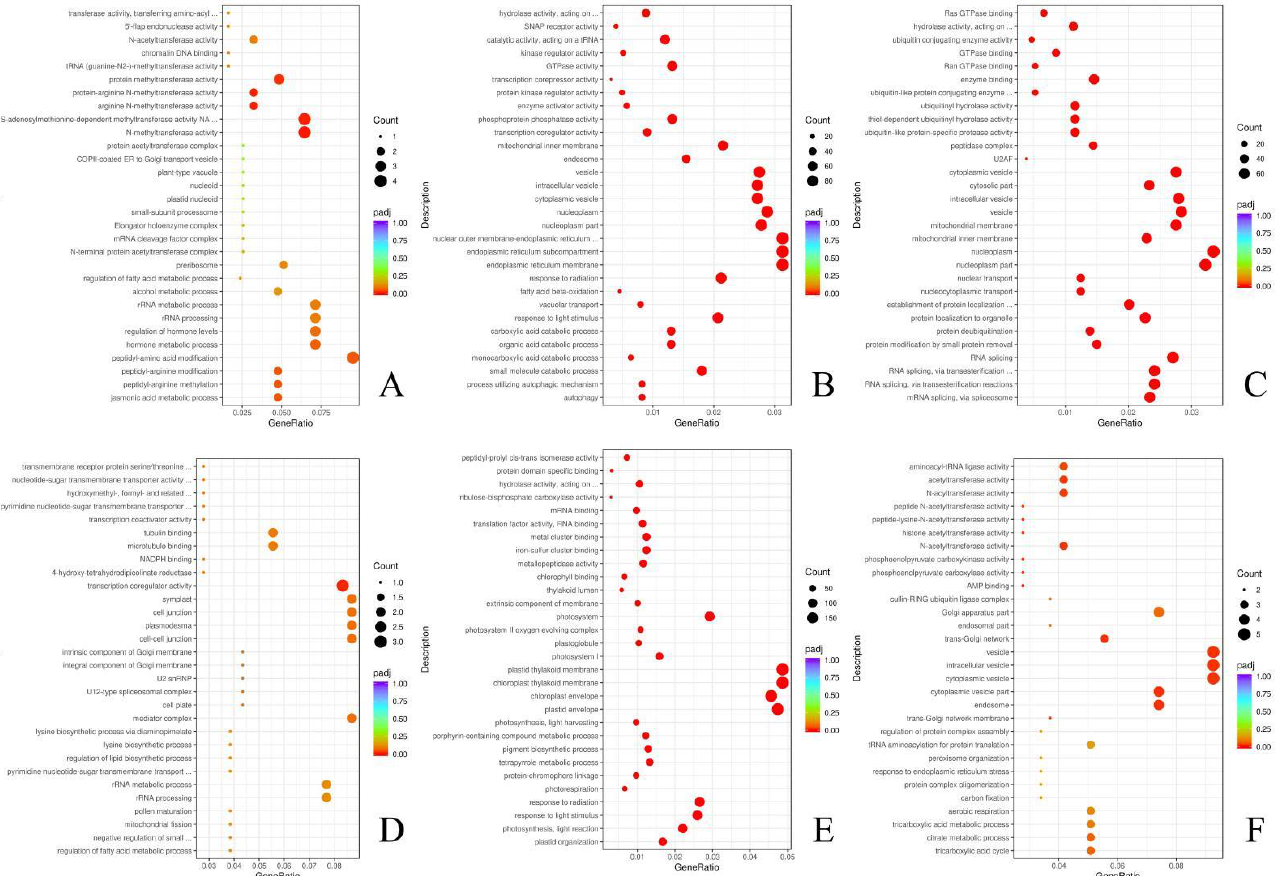
Figure 5. GO enrichment analysis of the interested modules related to powdery mildew stress. ( A ) Midnightblue module; ( B ) Blue module; ( C ) Brown module; ( D ) Lightcyan module; ( E ) Turquoise module; ( F ) Tan module. The size of the bubble represents the number of enriched genes. The Padj represents adjusted p value by a multiple hypothesis test, which is indicated by the bubble color with a legend on the right.